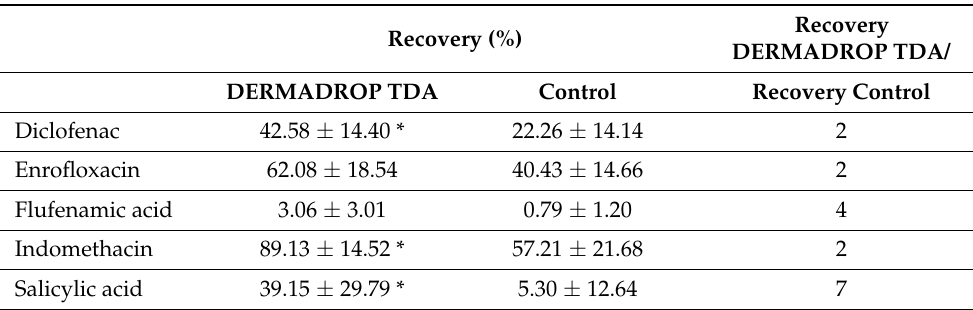
Table 3. Recoveries of the different drugs applied via DERMADROP TDA and via pipette after 28 h. Asterisks (*) indicate p < 0.05 (Mann–Whitney Test).